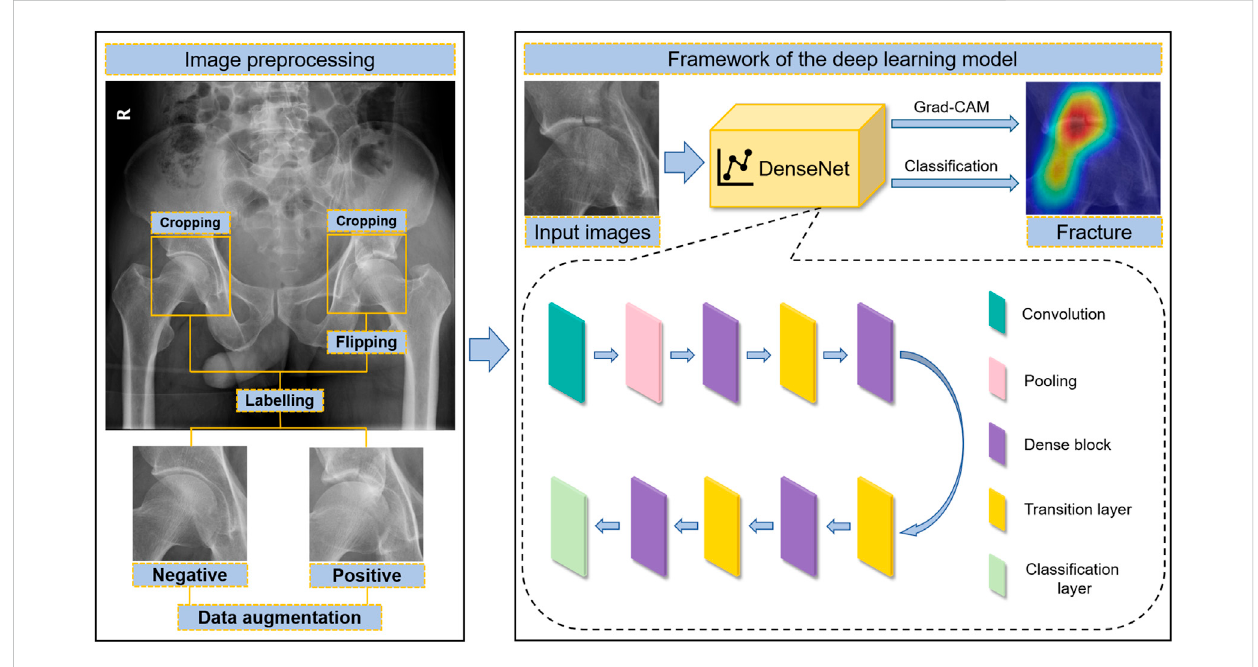
FIGURE 1 The work fl ow of acetabular fracture detection by arti fi cial intelligence, including image preprocessing and the framework of the DL model.